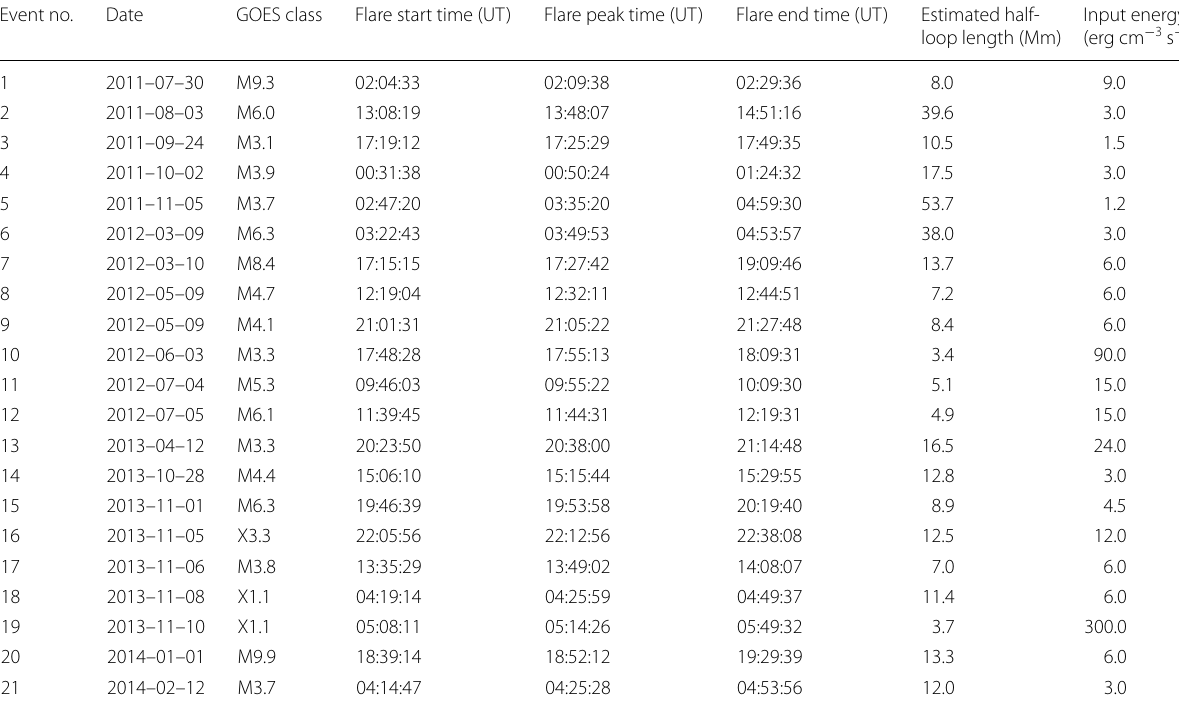
Table 2 Flare event list for this study